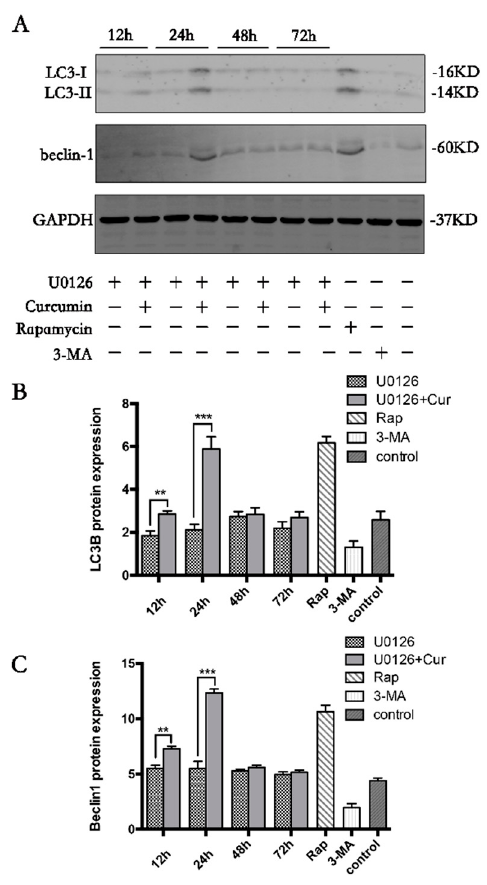
Figure 6. Curcumin could activate autophagy for U0126-induced inhibition of ERK1/2 in primary chondrocytes. Accumulation of beclin-1 and LC3-II upon autophagy activation was visualized by western blot (( A ), quantified in ( B ) and ( C )). Results in ( B , C ) are expressed as means ± SD for experiments performed in triplicate.* p < 0.05, ** p < 0.01, and *** p < 0.001. Rap, rapamycin; 3-MA, 3-Methyladenine.